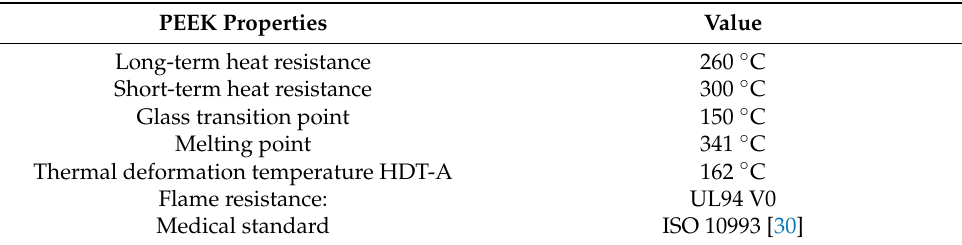
Table 1. PEEK properties; heat resistance and stability